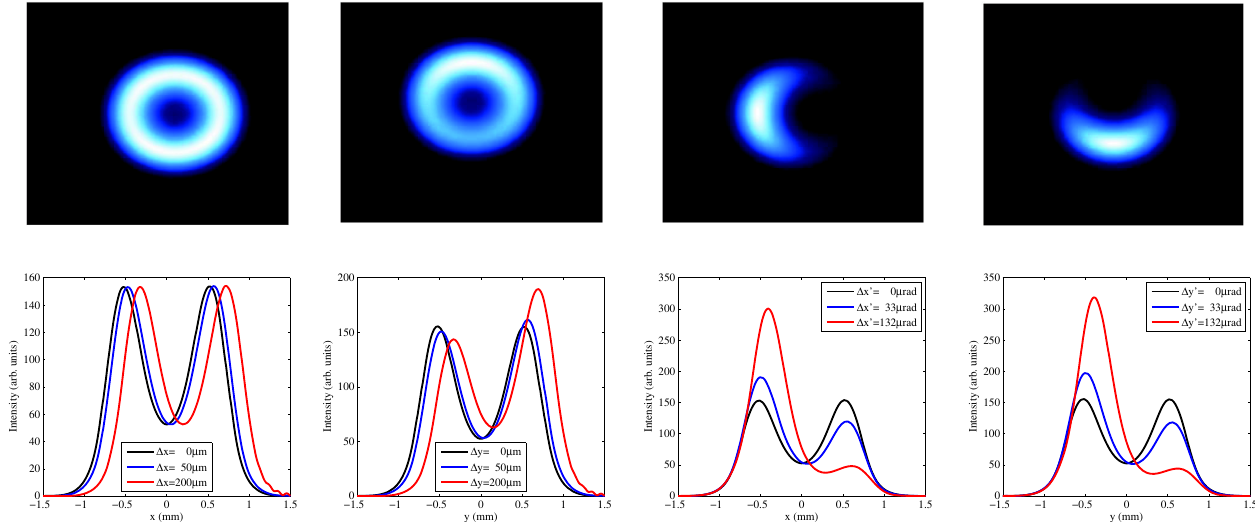
FIG. 7. The spatial distributions (the upper) and the central part projection (the lower) of the coherent photon beam with controlled electron beam offset and tilted injection with respect to undulator axis. Spatial distributions in the upper row correspond to the red lines in the plots in the lower row.